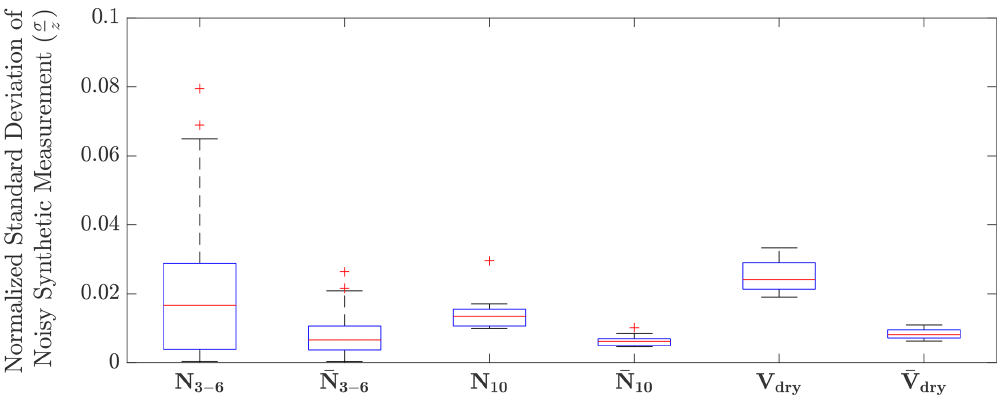
Figure 6. Box plot showing the standard deviation of “noisy synthetic measurements” relative to their average value in all 27 scenarios for the inventory variables originally ( N 3–6 , N 10 , V dry ) and after filtering ( N 3–6 , N 10 , V dry ).